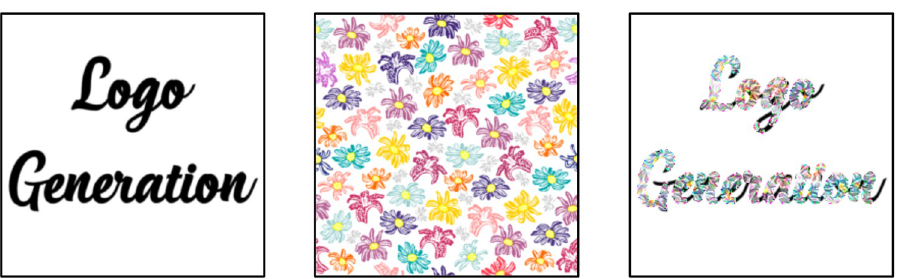
Fig 9. Examples of logo generation using the proposed